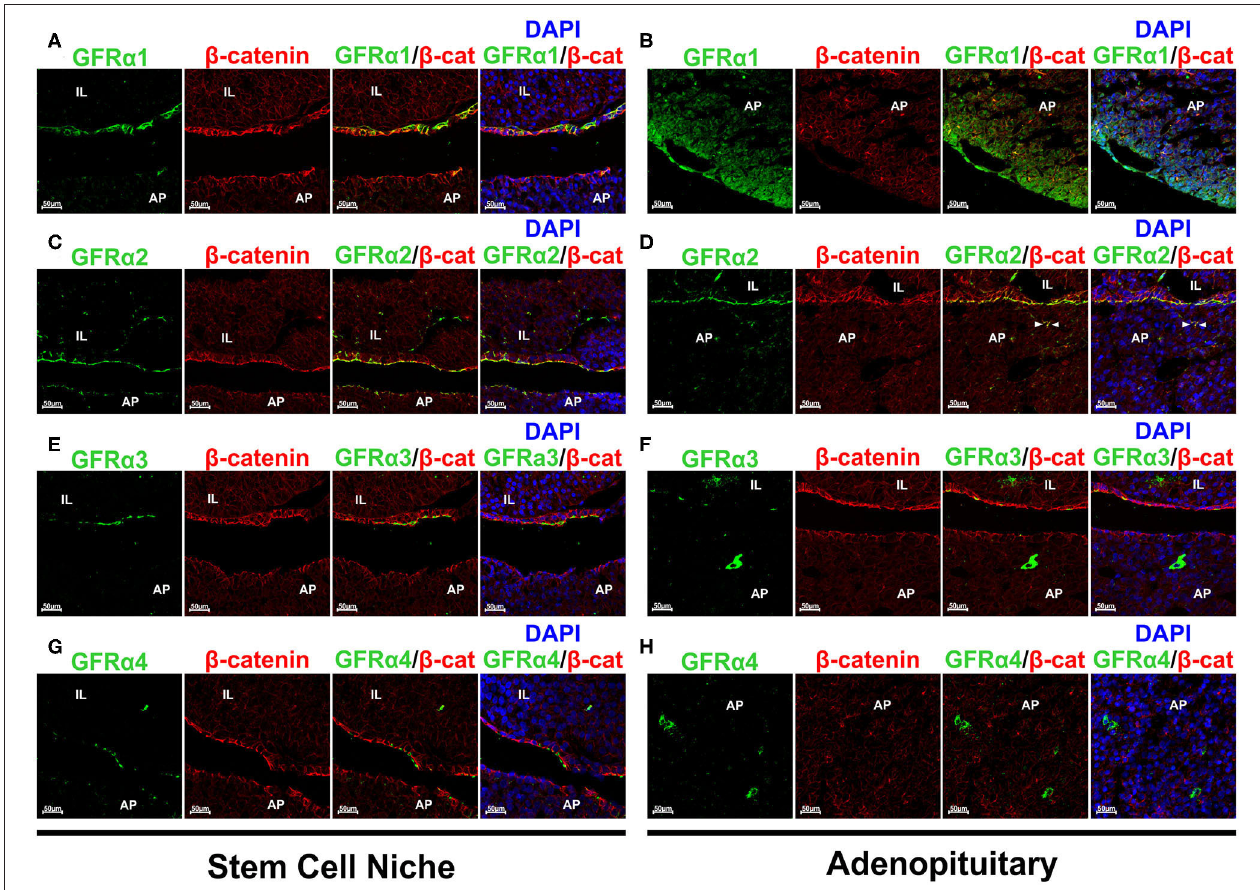
FIGURE 3 | Expression of the GFR α 1-2-3 and 4 co-receptors in rat pituitary. Sections were double stained for each one of the co-receptors and β -catenin to reveal the pituitary stem cell niche. (A) GFR α 1 (green) colocalizes with β -catenin ( β -cat, red) at the GPS niche (yellow blended color in the combined projection). However, GFR α 1 cells at the adenopituitary do not co-express β -catenin (B) . DAPI is shown to reveal the nuclei. (C) GFR α 2 is continuously expressed along the pituitary stem cell niche, at the apical pole of the GPS cells. It is co-expressed with β -catenin. (D) There are few GFR α 2 cells through the AP and are also GPS cells located at the pituitary follicles as shown by co-expression with β -catenin (arrowheads). (E) GFR α 3 is also co-expressed with β -catenin at the apical pole of the GPS cells. (F) There are isolated GFR α 3 expressing cells that do not express β -catenin. (G) GFR α 4 is also colocalized with β -catenin at the niche. (H) Isolated GFR α 4 cells negative for β -catenin were found in the AP (Left) but also—and numerous- in the IL (Right). AP, Adenopituitary; IL, Intermediate Lobe; NP,